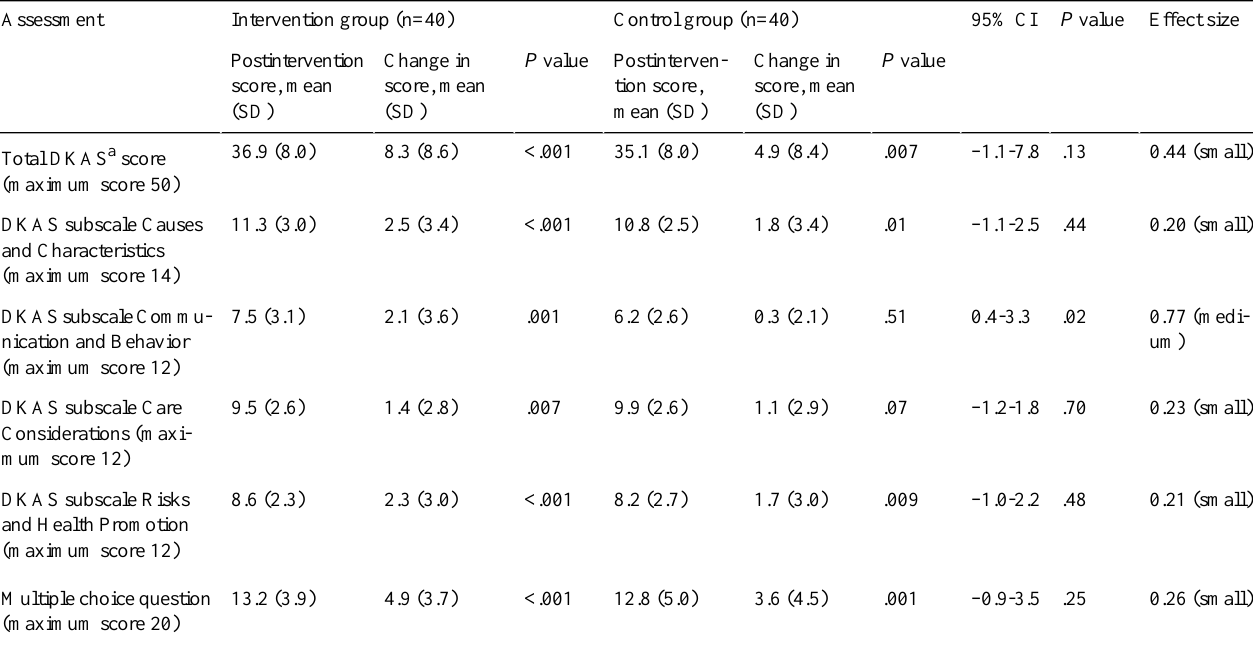
Table 3. Scores and the comparison of changes in scores at postintervention knowledge assessment.